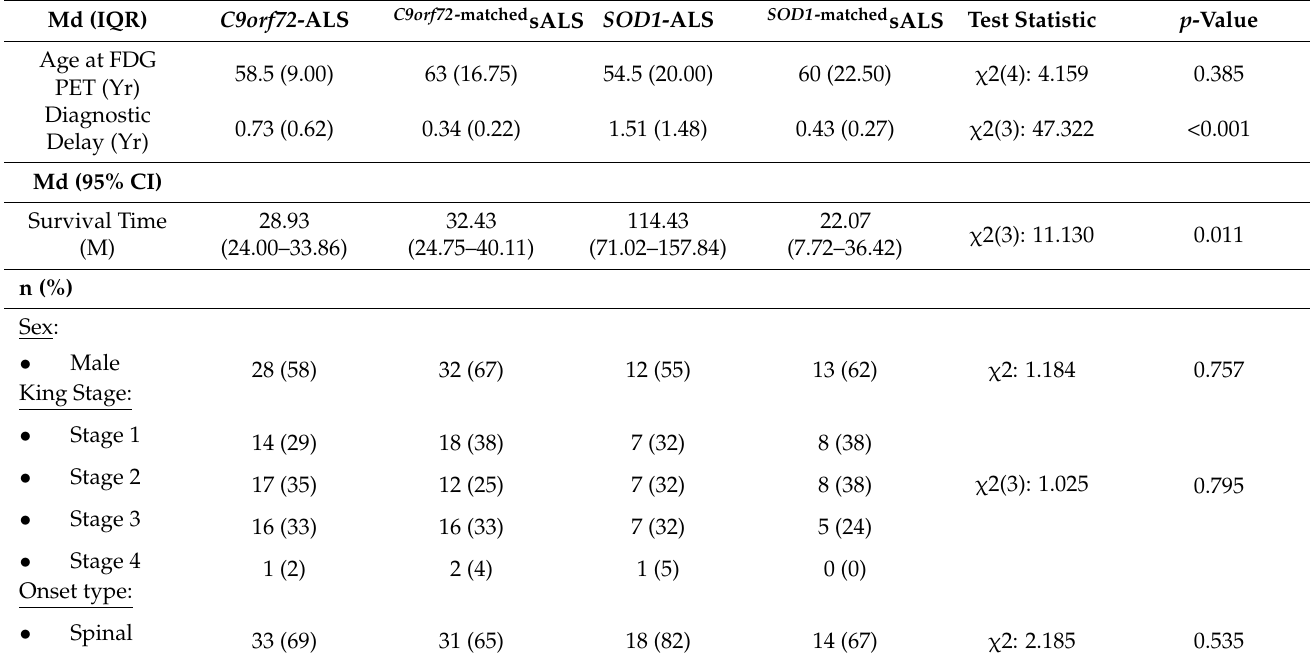
Table 1. Demographics and clinical characteristics of ALS patient groups (healthy controls, n = 20; C9orf72 -ALS, n = 48; C9orf72 -matched sALS, n = 48; SOD1 -ALS, n = 22; SOD1 -matched sALS, n = 21). Abbreviations: C9orf72-ALS, C9orf72-associated ALS; CI, confidence interval; IQR,